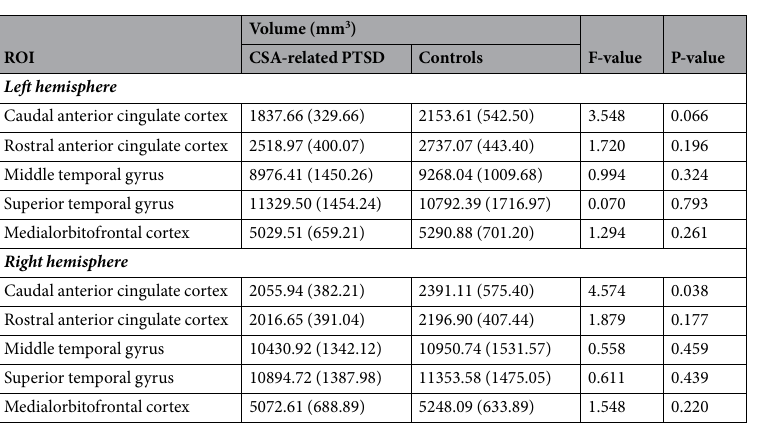
Table 4. Contributions of each ROI’s volume. Abbreviations: CSA, Childhood Sexual Abuse; PTSD, Post Traumatic Stress